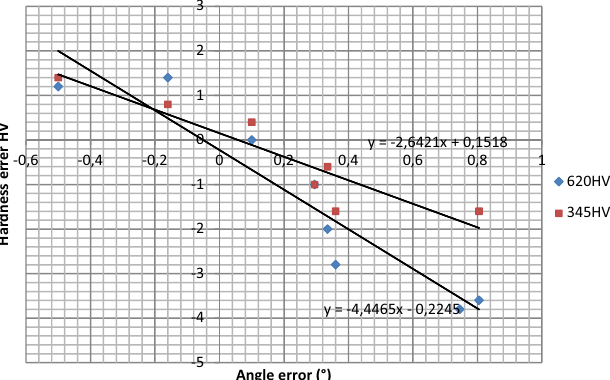
Fig. 6. (Color online) Hardness error due to angle error. the best fit line given in Figure